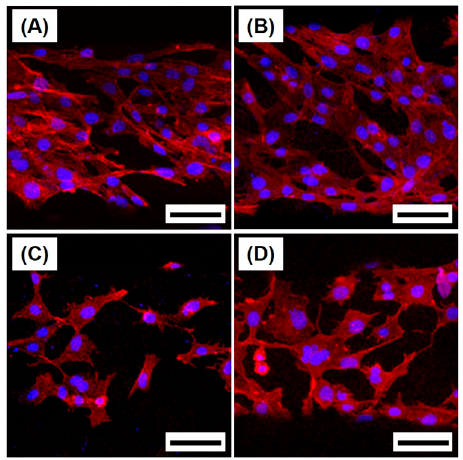
Figure 7. ( A ) Representative stress versus strain responses of the macro/micro-porous PCL/HA composite scaffolds produced with various HA contents (0 wt % (PCL), 10 wt % (HA10), 15 wt % (HA15), and 20 wt % (HA20)) under compression and ( B ) compressive yield strength of the scaffolds. The right graph in Figure 8A displays the stress versus strain responses during the early stage of compressive loading.